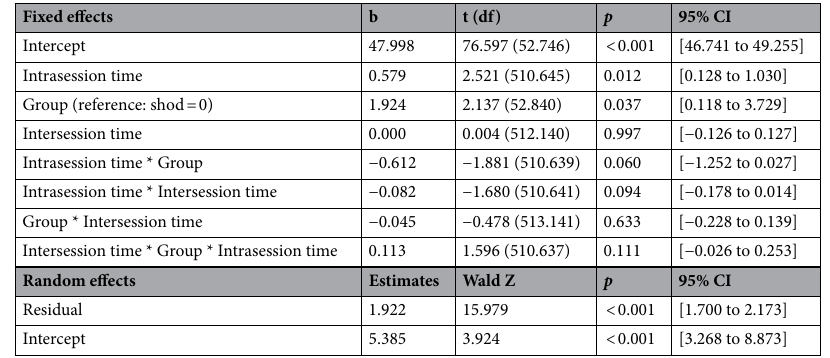
Table 2. Effects of group (shod n = 17; barefoot n = 20), intersession time (the 7 sessions), intrasession time (the beginning, middle, and end of each session), and all possible interaction effects on dynamic running stability (the largest Lyapunov exponent). The effects were analysed with a linear 2 level random intercept model.